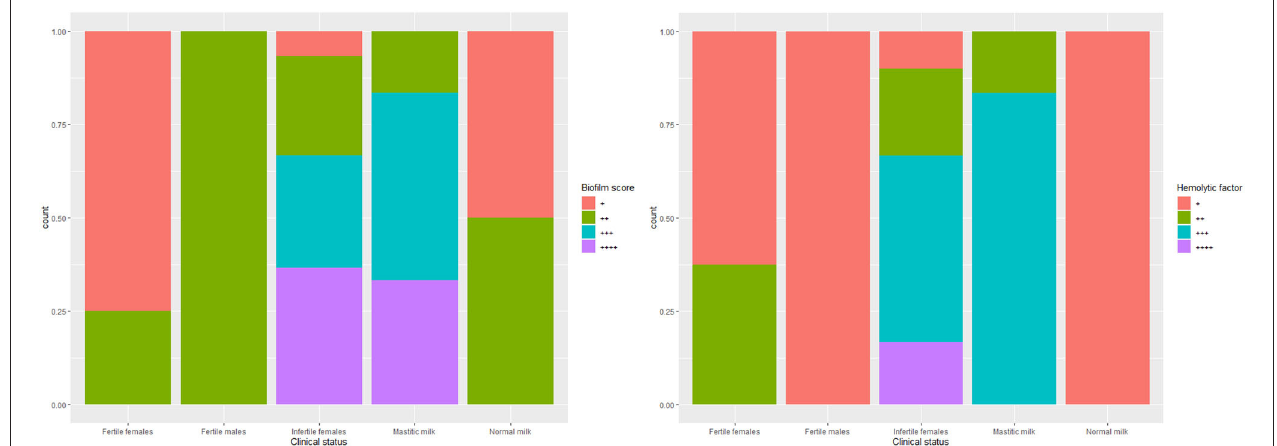
FIGURE 7 | The strength of biofilm formation and hemolysin activities of C. albicans isolates from milk and genital tract of dromedary camel.